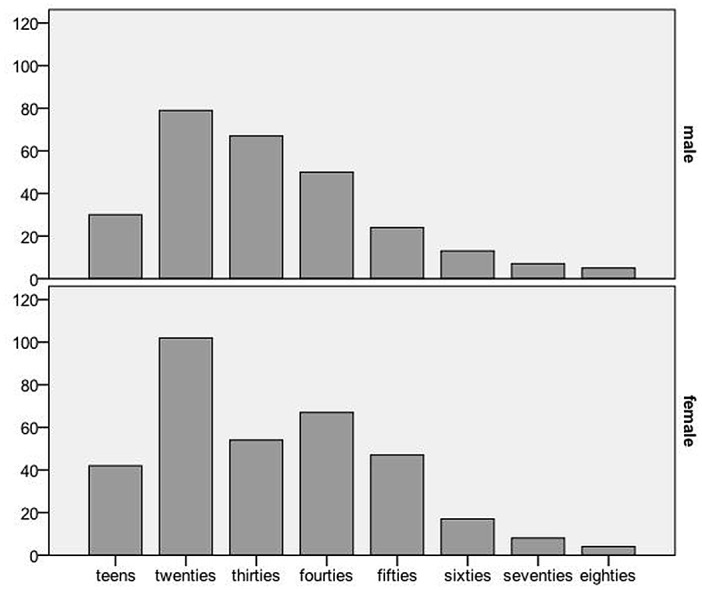
Age distribution.